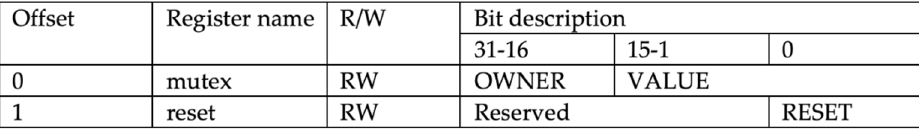
Figure 7. Register map of a mutex core.